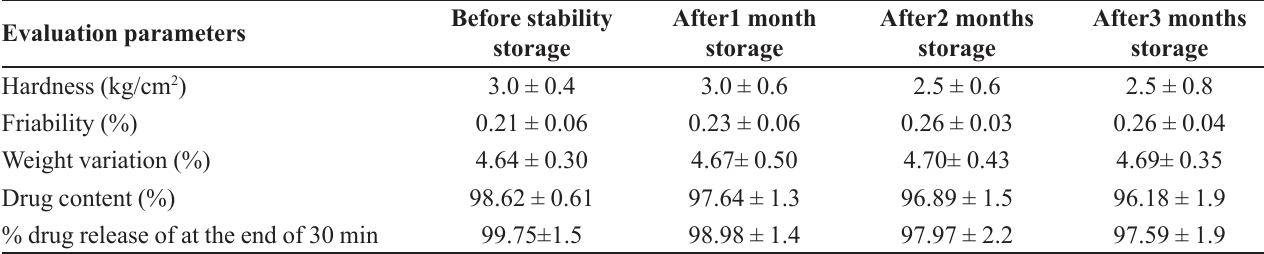
TABLE VI - Evaluation parameters of stability batch (C6) Evaluation parameters